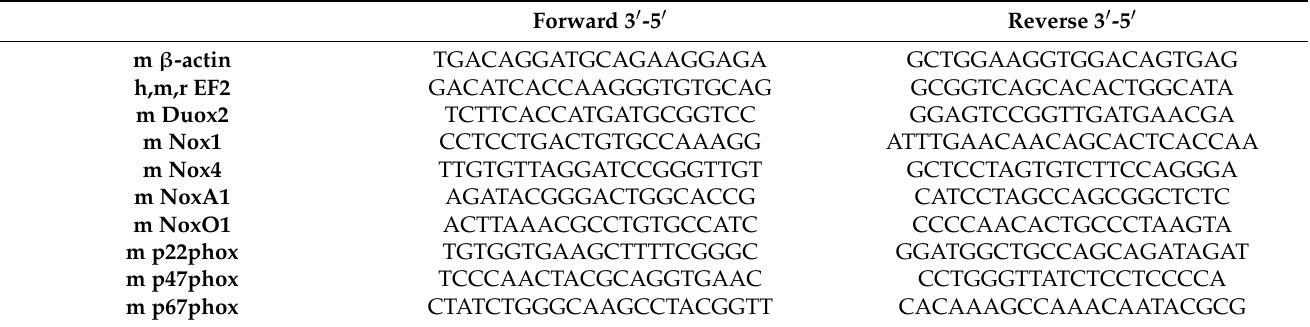
Table 1. Primer Sequences for